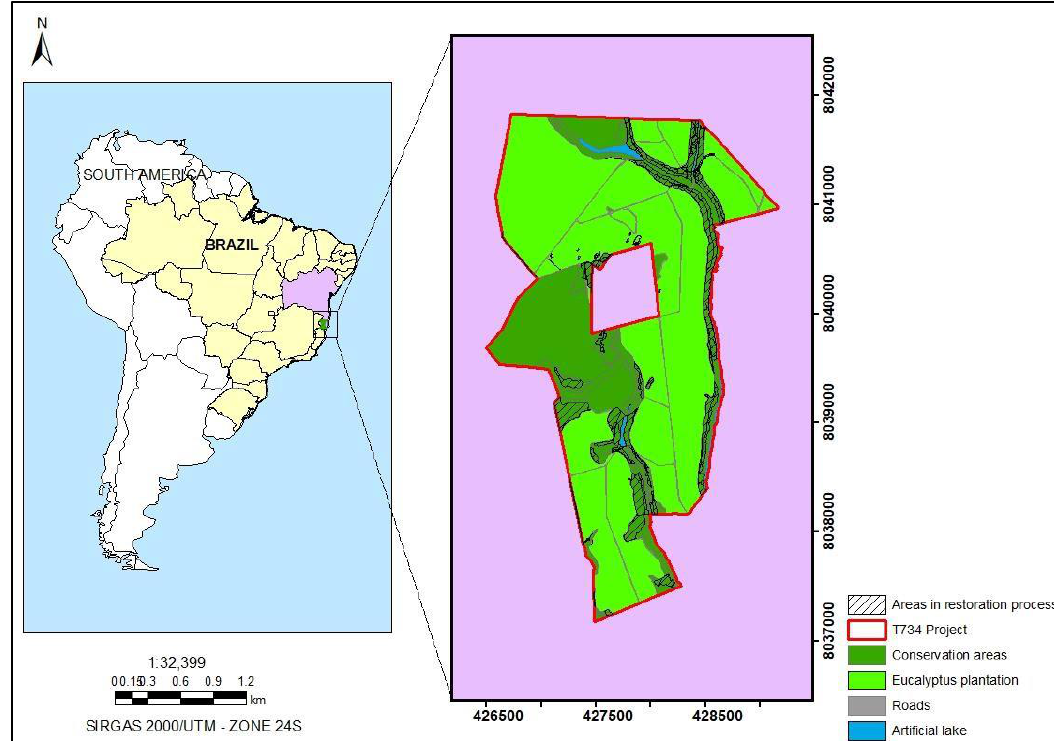
Figure 1. Location and land use of the study site called “Project Maria Mirreis T734” in the southern part of the Bahia state, Brazil.